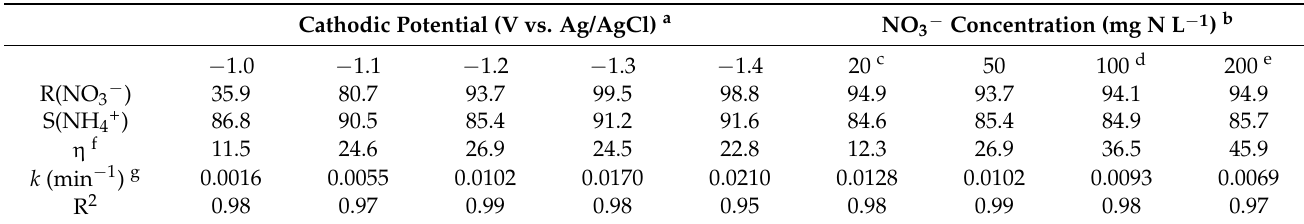
Table 1. Summary of electrochemical NO 3 − reduction with Co 3 O 4 − x /NF cathode. Cathodic Potential (V vs. Ag/AgCl) a